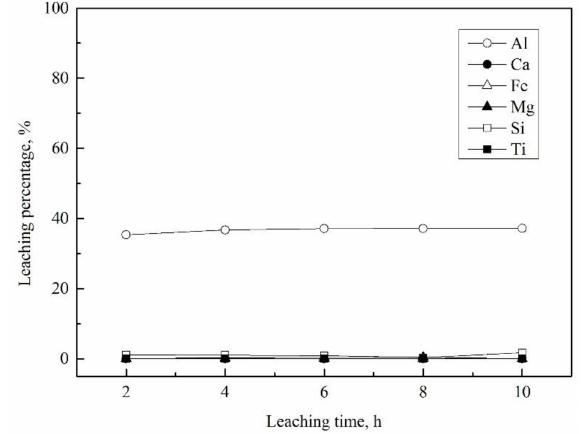
Figure 9. The effect of reaction time on the leaching of the oxides from the mechanically activated dross